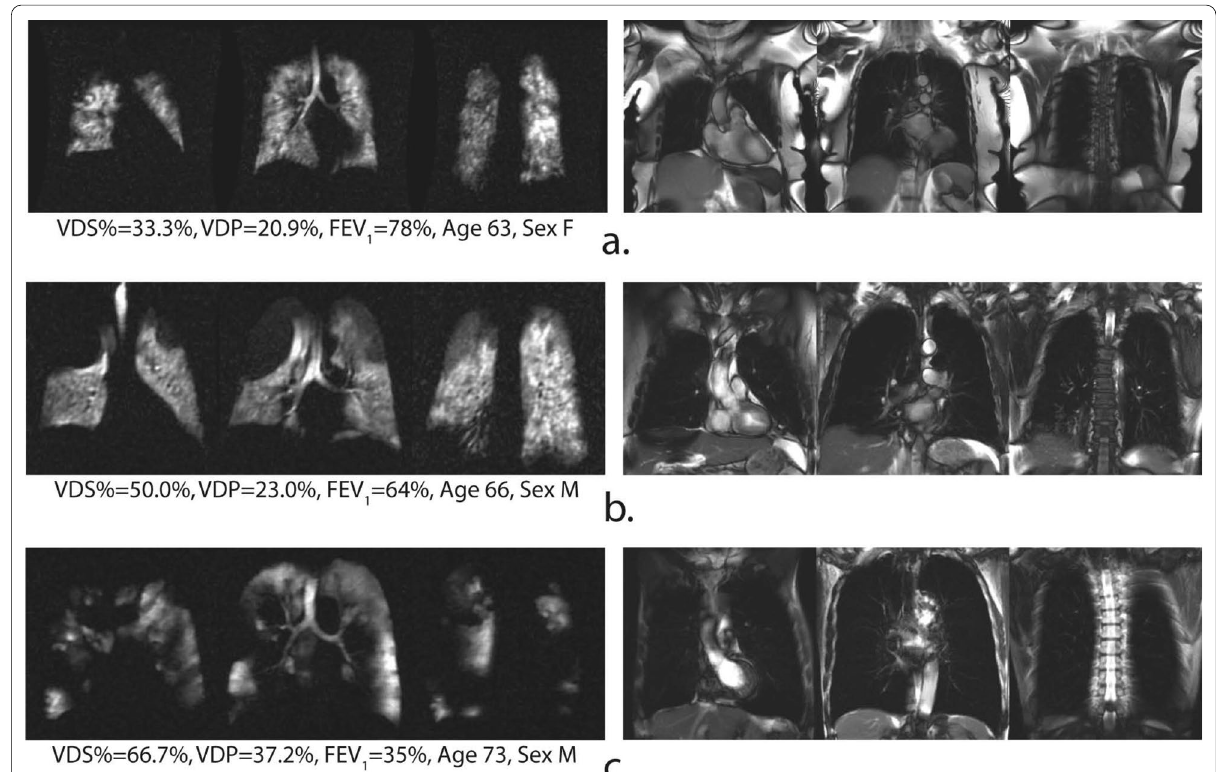
Fig. 8 Representative 129Xe ventilation (left) and 1H SSFP anatomical image (right) slices of three COPD subjects. Note, a variety of ventilation defects score percentage (VDS%) are observed increasingly from 33.3% ( a ), 50.0% ( b ) to 66.7% ( c ) throughout the lungs. SSFP; Steady-state Free Precession. Reproduced with permission from John Wiley and Sons (License Number: 5324291003853). NMR Biomed. 2013 April; 26(4): 424–435